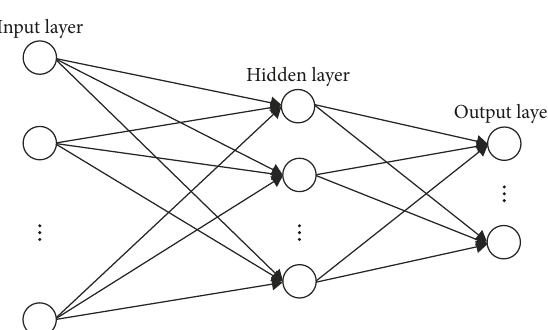
Figure 10: Structure chart of the BP neural network. The BP neural network consists of three layers: input layer, hidden layer, and output layer. The number of nodes in the input layer, the hidden layer, and the output layer is 120, 100, and 12,